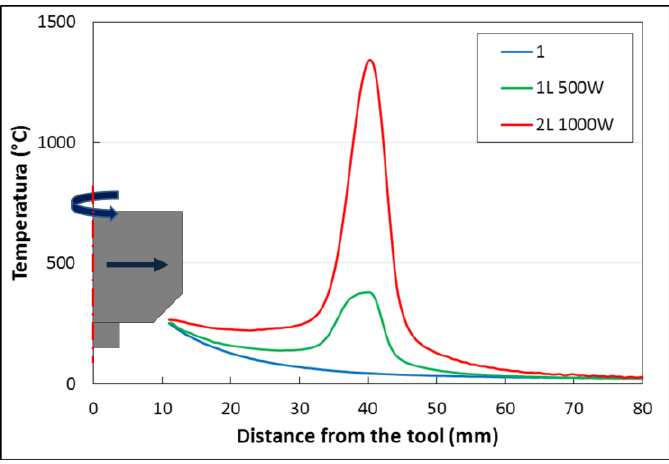
Figure 13. Comparison of temperature profiles along the weld junction between the friction stir welding and laser friction stir welding at 500 and 1000